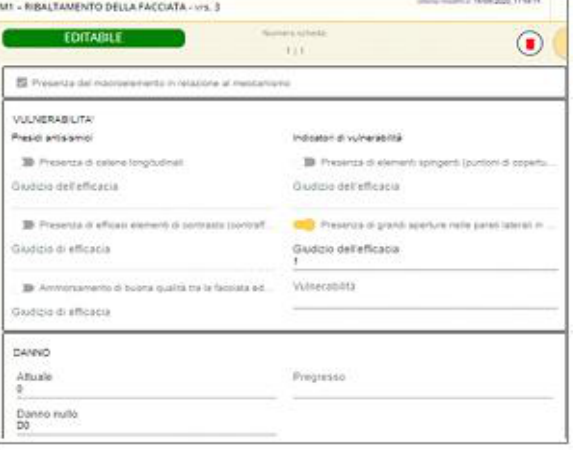
Figure 10 . Structural information: on-line fillable data sheets.